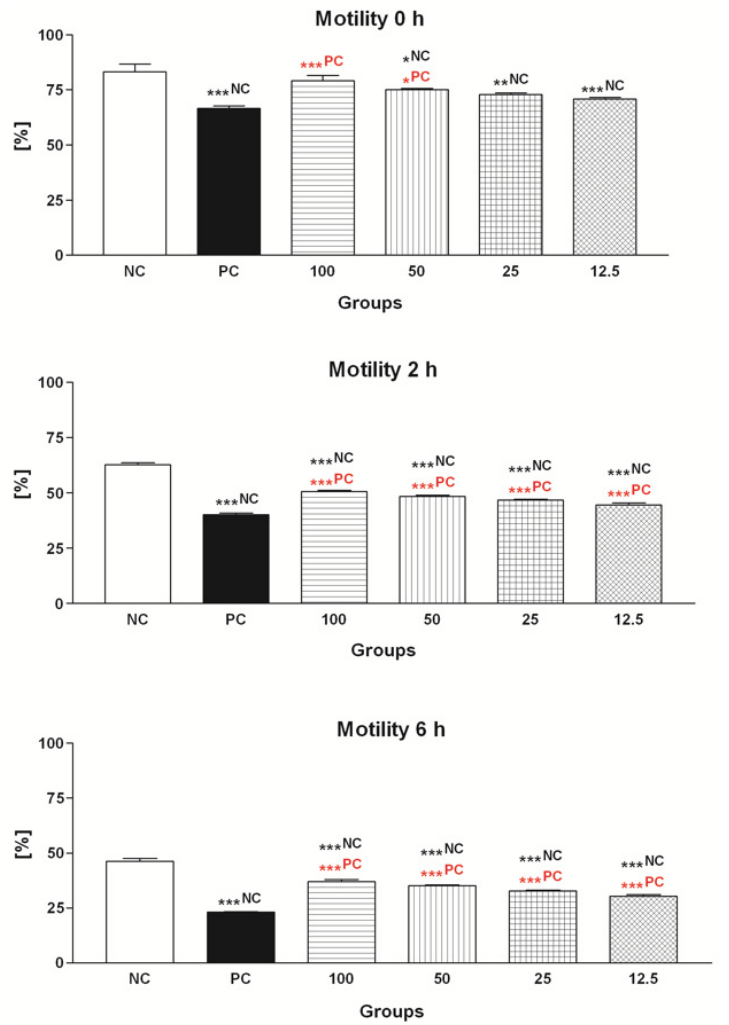
Figure 1. Motility of bovine spermatozoa exposed to four doses of epicatechin (EPI; µ mol / L) in the presence of ferrous ascorbate (FeAA). The data were obtained from five independent experiments. * p < 0.05; ** p < 0.01; *** p < 0.001. NC—vs. negative control; PC—vs. positive control.